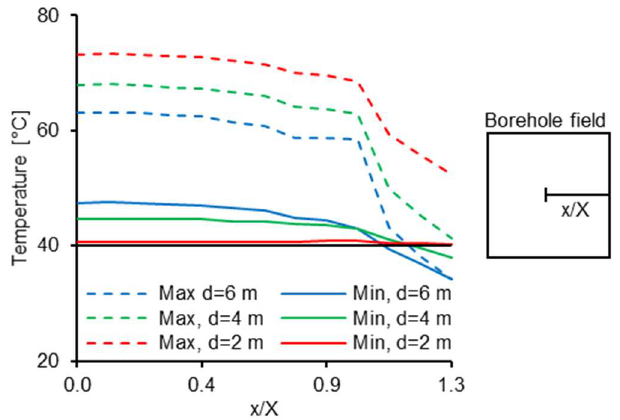
Figure 13. Horizontal temperature distribution at half the borehole depth for when the temperatures within the borehole field at the considered line are at their annual minimum and maximum respectively. x is the distance from the borehole field centre and X is the distance between the borehole field centre and its border. The black line indicates minimum useful temperature.